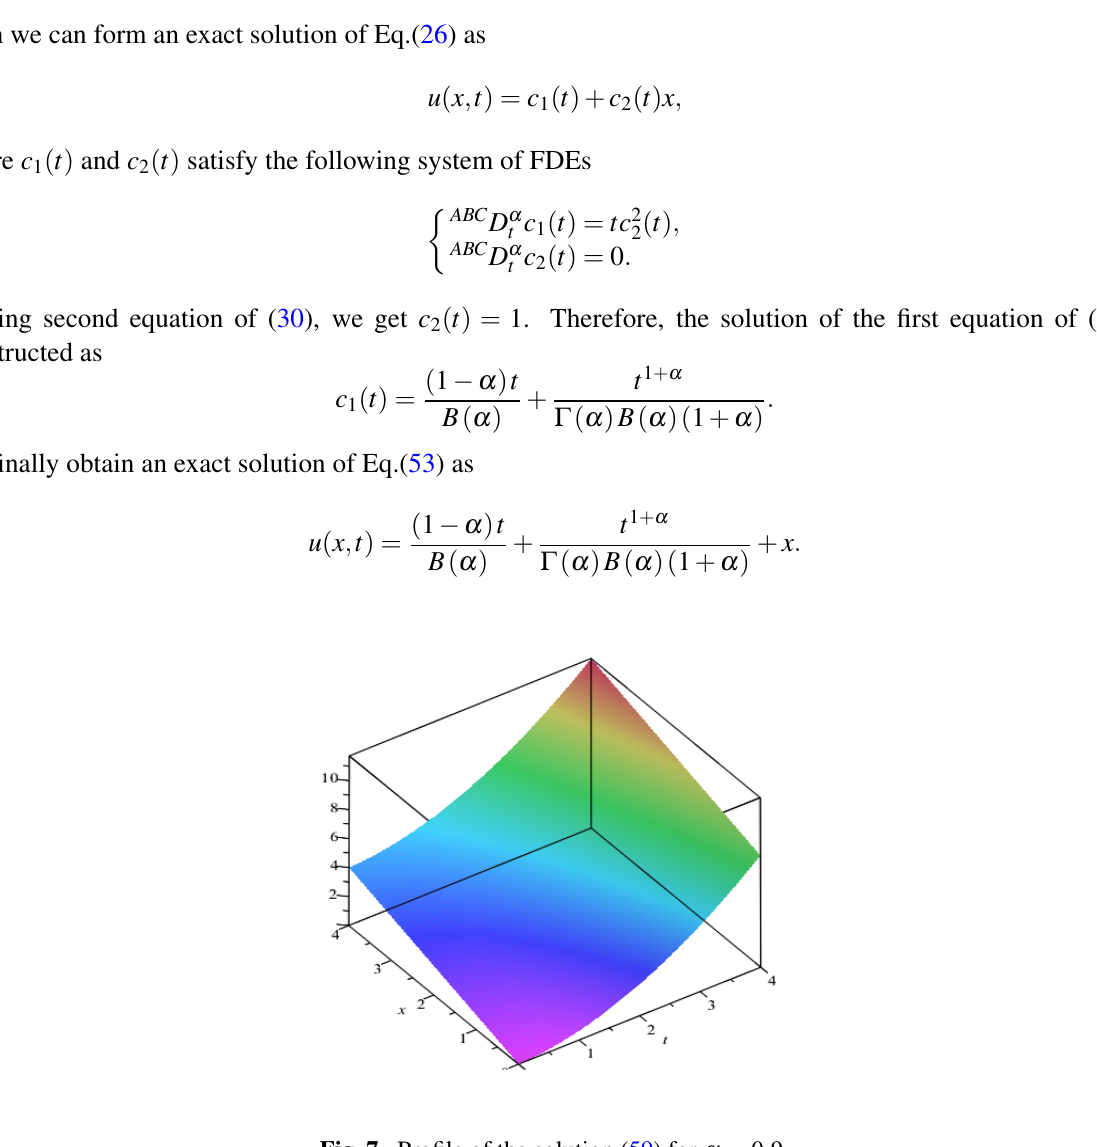
Fig. 7 Profile of the solution (59) for α = 0 . 9